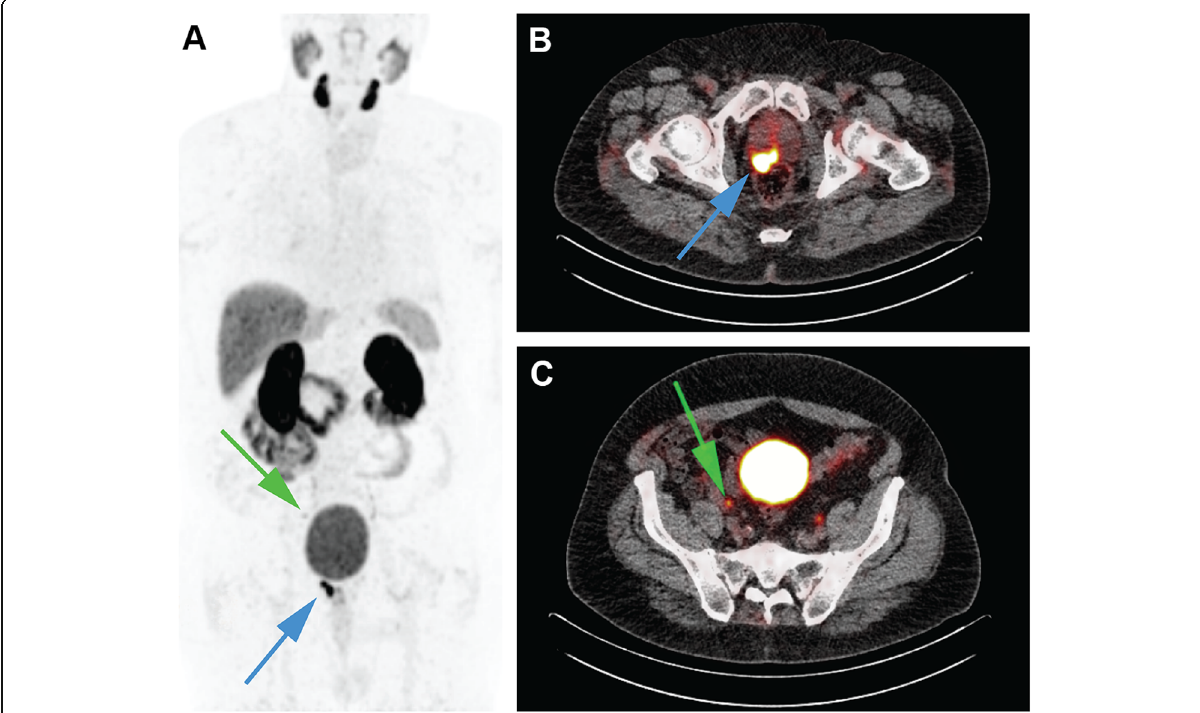
Fig. 2 Preoperative tumor mapping using PSMA-PET. a Example of total body PET maximum intensity projection with tumor focus in prostate (blue, upwards arrow) and lymph node metastasis (green, downwards arrow). b PET/CT slice of the same patient illustrating a clear tumor focus within the prostate (blue arrow; SUV mean = 17.8). c PET/CT slice of the same patient displaying a lymph node metastasis (green arrow; SUV mean =